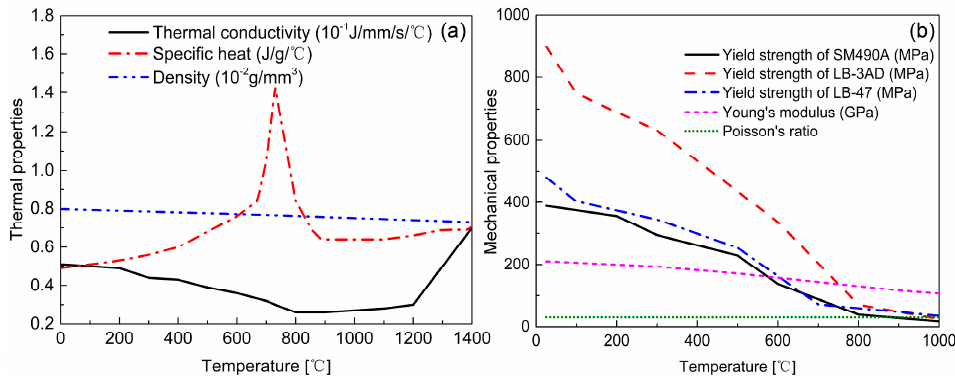
Figure 4. Material properties of the LTT weld metal: ( a ) thermal properties; ( b ) mechanical proper- ties.